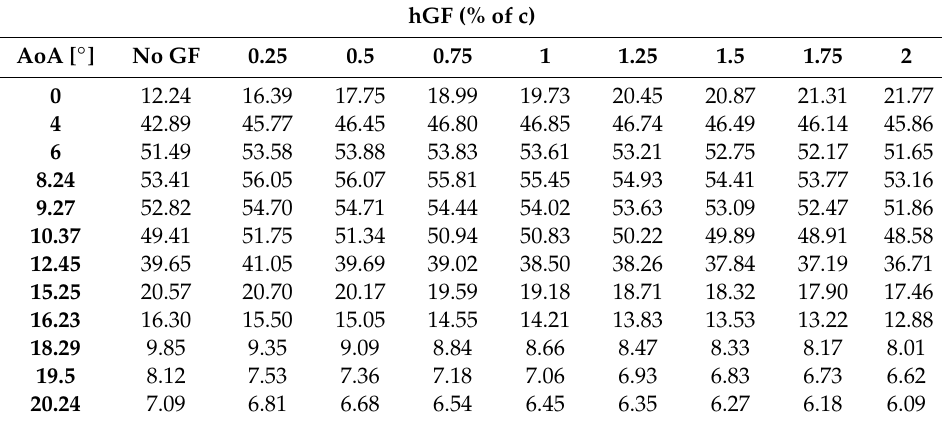
0.5% of hGF a maximum peak value of C L /C D = 56.069 was reached. For higher AoAs, the curves